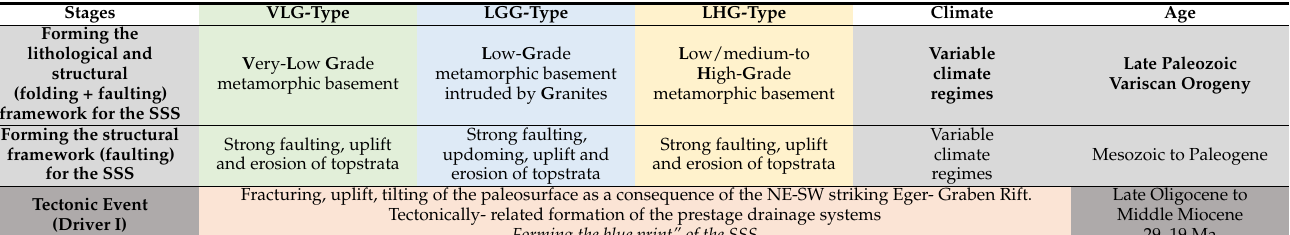
Table 5. The Quadripartite approach to the evolution of the straight to low-sinuosity drainage system (SSS) in a mature basement and its immediate foreland as a function of lithology and tectonic (see VLG-, LGG- and LHG types) and climate change during the Late Cenozoic. (1) The geological framework of SSS: Forming the lithological and structural features in the bedrock as a result of different temperature, pressure and dynamic processes. (2) Prestage of SSS: Forming the paleo-landscape with a stable fluvial regime. (3) Proto-SSS: Transition into a metastable fluvial regime. Modern SSS: Operation of the metastable fluvial regime with the tendency to achieve a stable regime at the boundary basement-foreland. Each compartment shows the geological and geomorphological processes and landforms essential for the evolution of the SSS together with the degree of sinuosity and the slope angle. The tectonic event denotes the onset of the SSS formation sensu lato